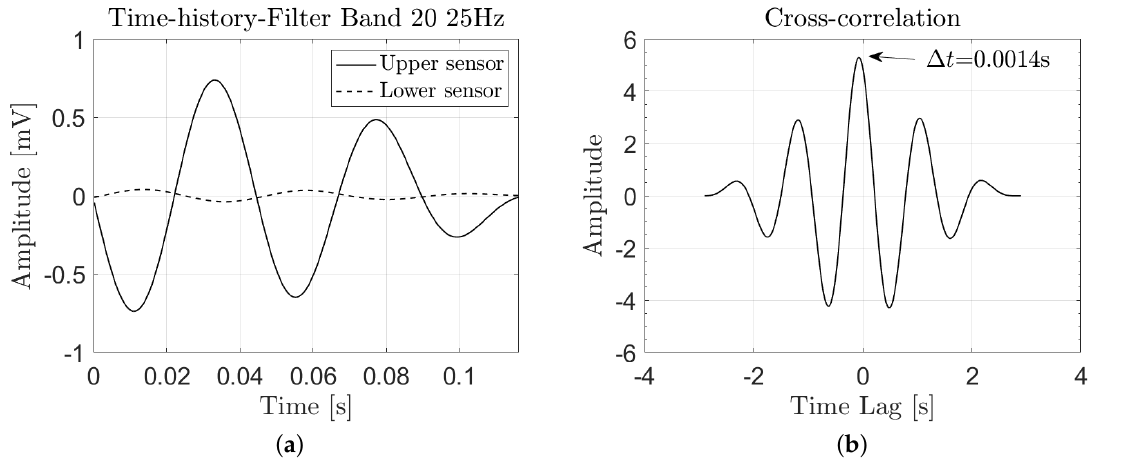
Figure 4. ( a ) Time history of the filtered signals, ( b ) Cross-correlation between the two filtered signals.